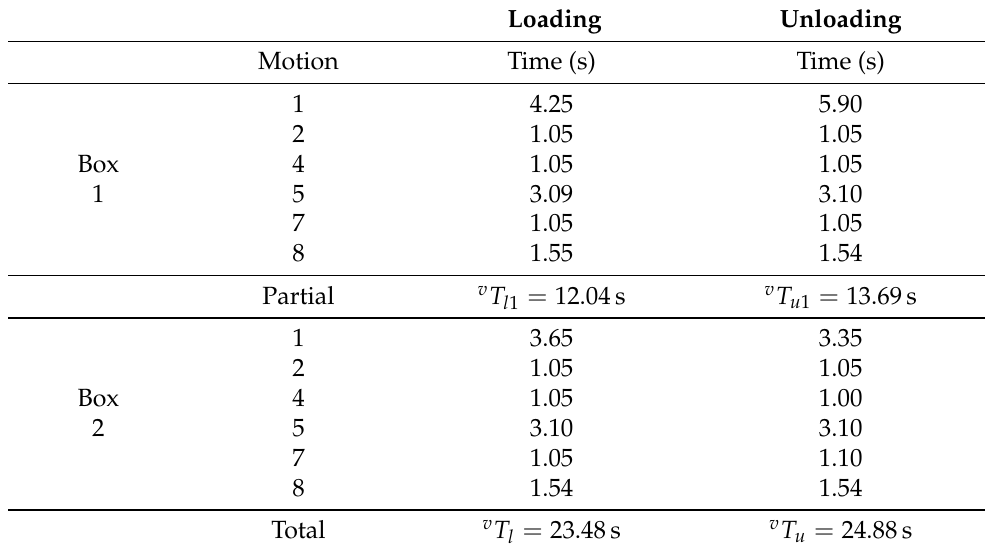
Table 2. Simulated elapsed time for loading/unloading two boxes with the vacuum